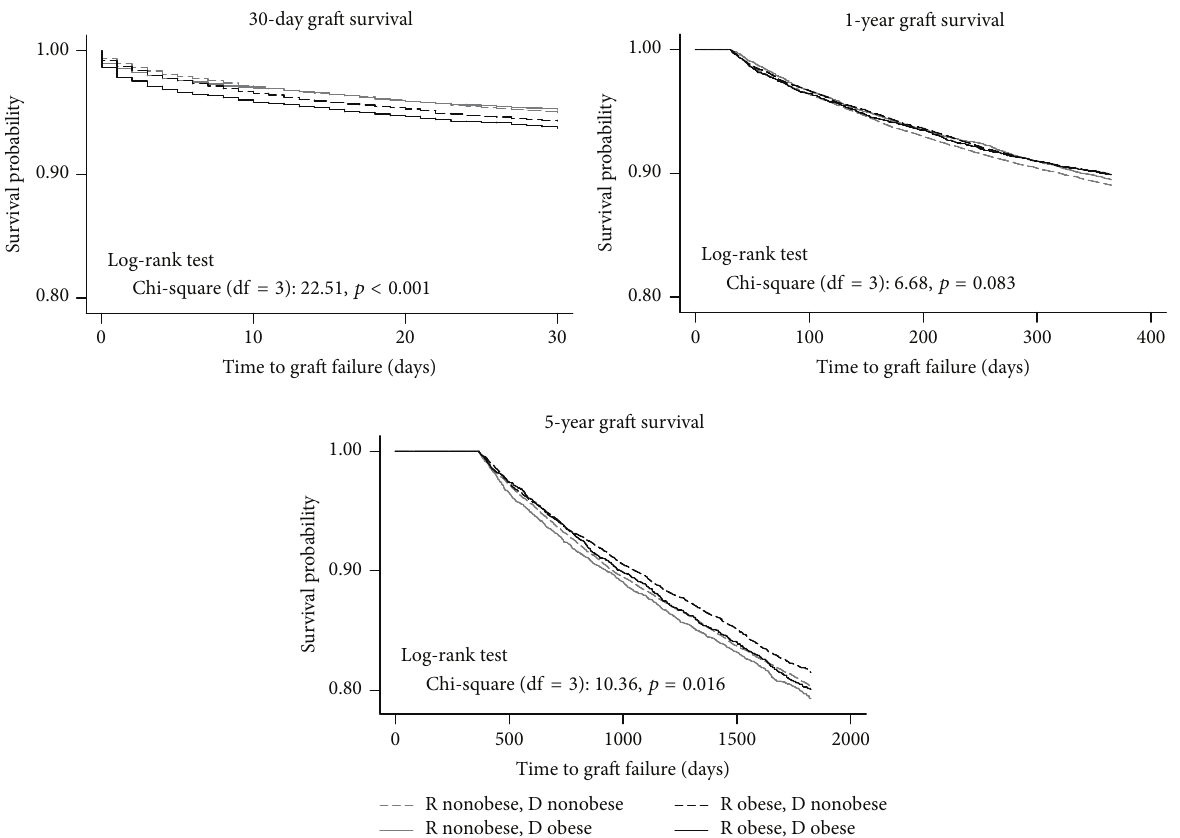
Figure 3: Kaplan-Meier 30-day, 1-year, and 5-year graft survival functions by recipient and donor obesity status ( 𝑁 = 51